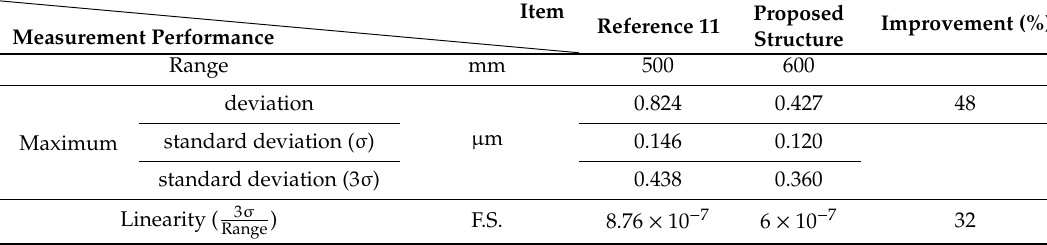
Table 3. The comparison result between the published and the proposed measurement